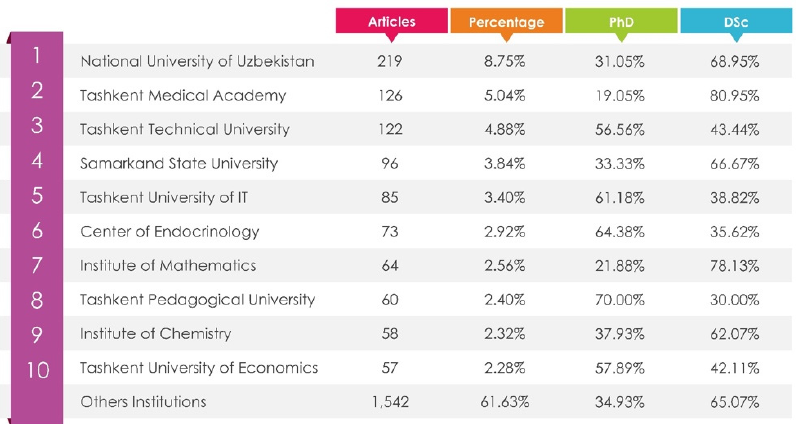
Figure 4. Top-ten universities and institutions based on the number of publications.